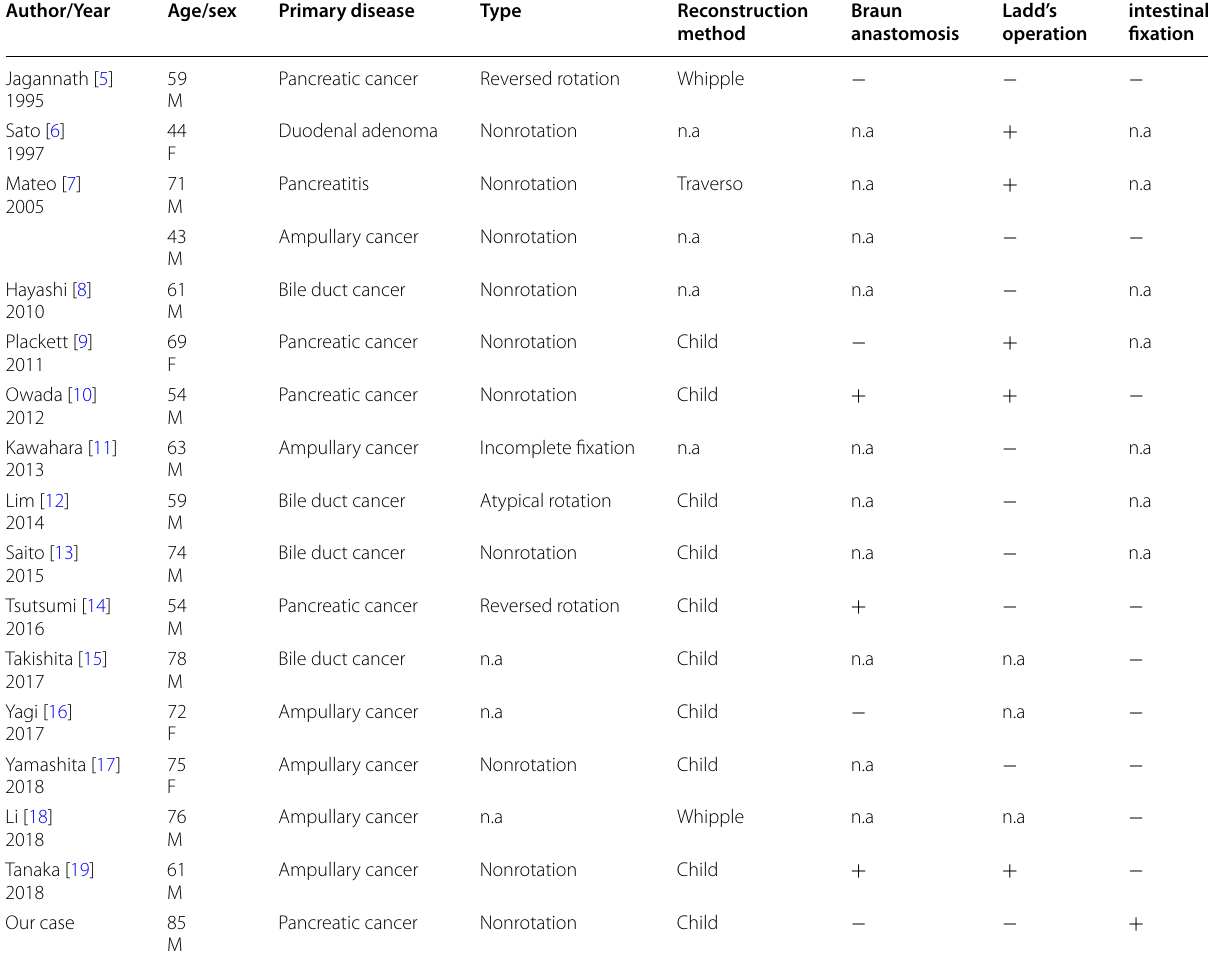
Table 1 Reported cases of pancreaticoduodenectomy with intestinal malrotation